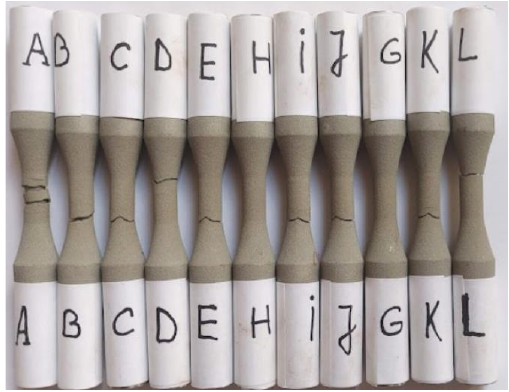
Figure 5. Samples after fatigue testing: A: static tensile sample; B–L: fatigue tested